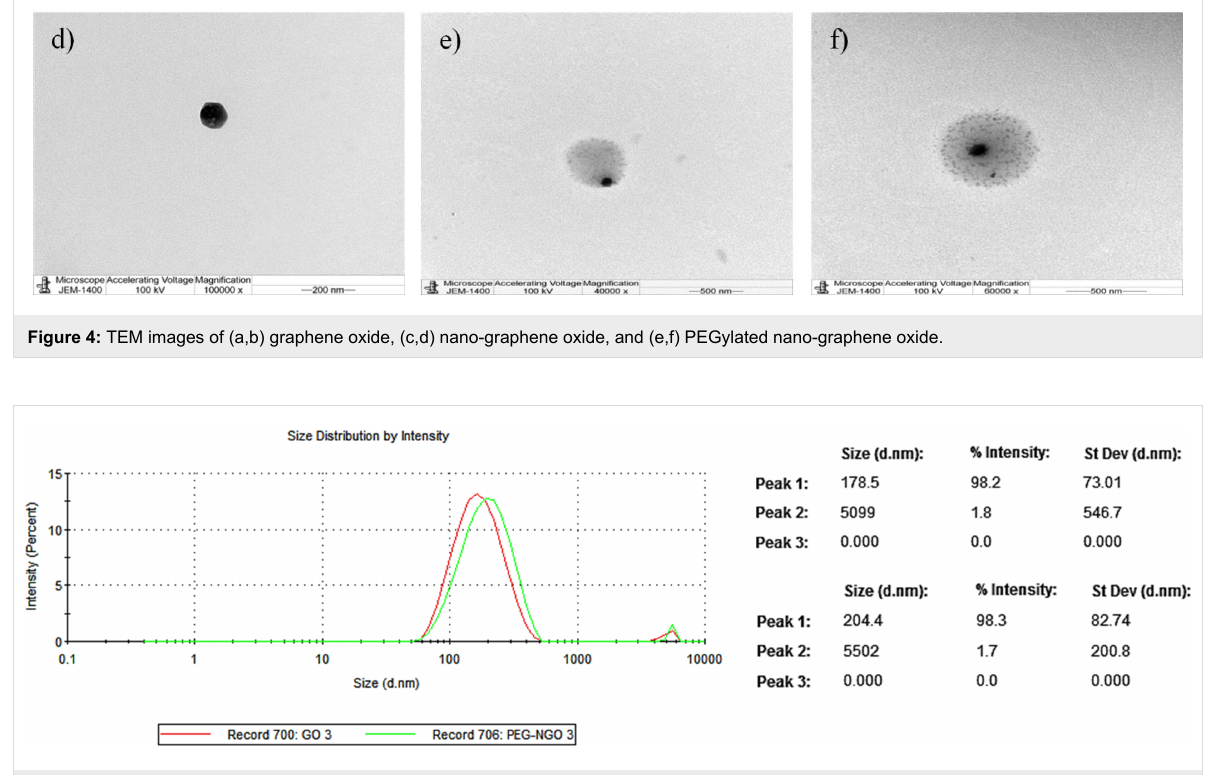
Figure 5: Particle size distribution curves for nGO and PEG-nGO.